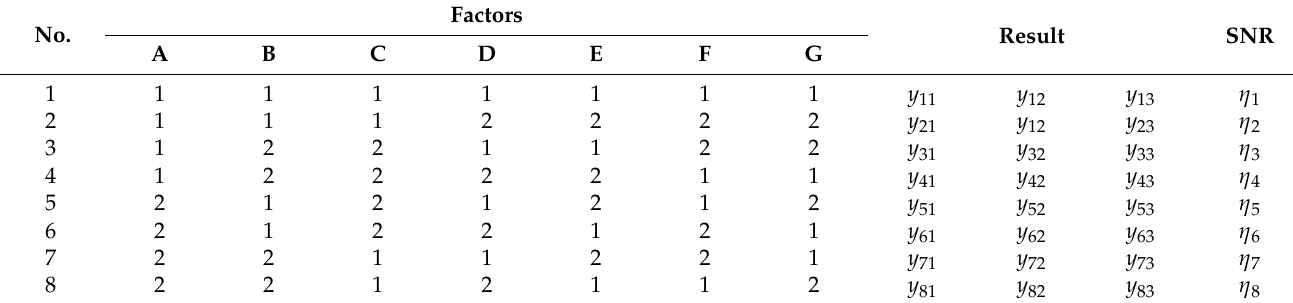
Table 4. A usage table of the U 11 uniform layout.